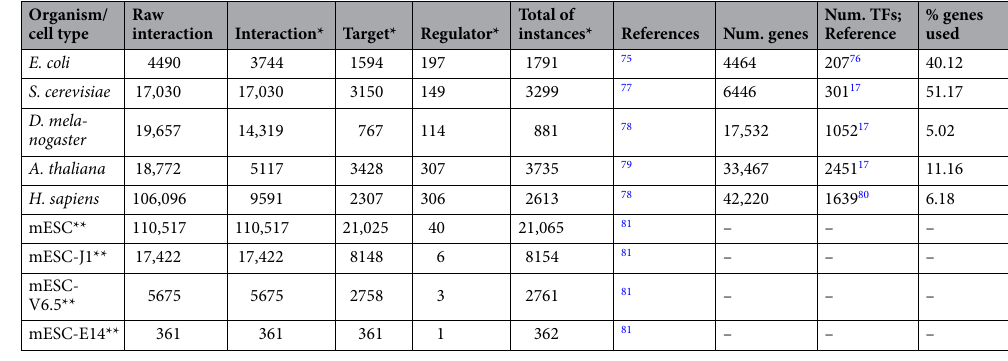
Table 1. The number of interactions, regulators, and targets of analyzed GRNs. * Number of interactions and nodes after filtering. ** Datasets exclusively used as test sets. The number of genes per species were retrieved from NCBI (accession numbers GCF_000005845.2, GCF_000146045.2, GCF_000001215.4, GCF_000001735.4, and GCF_000001405.39). The “Num. TFs” depicts the number of transcription factors of each species. The “% genes used” are the proportion between the “Total of instances” and the “Num. of